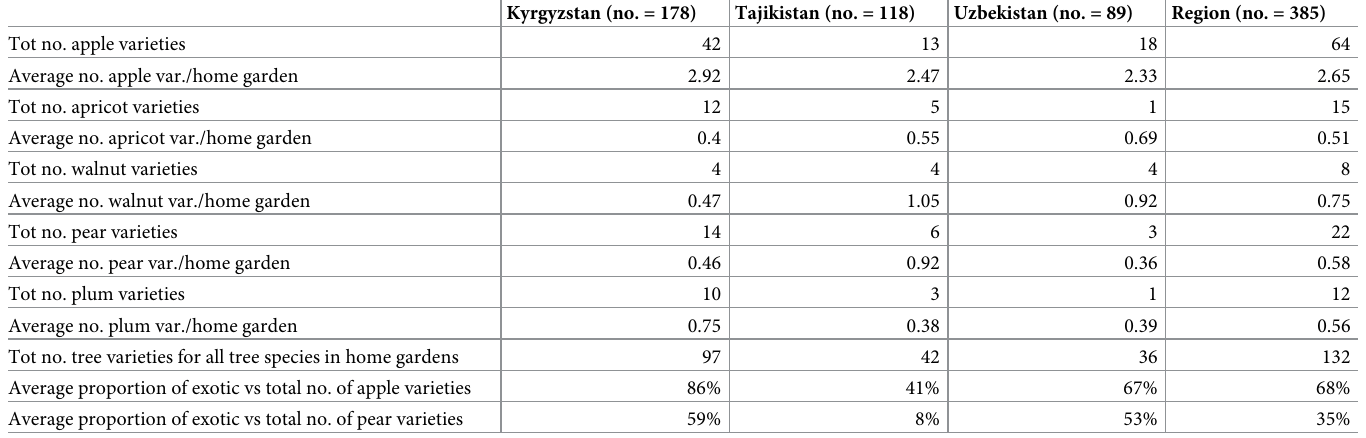
Table 4. Total and average number of varieties per home garden for five highly represented tree species. Kyrgyzstan (no. =